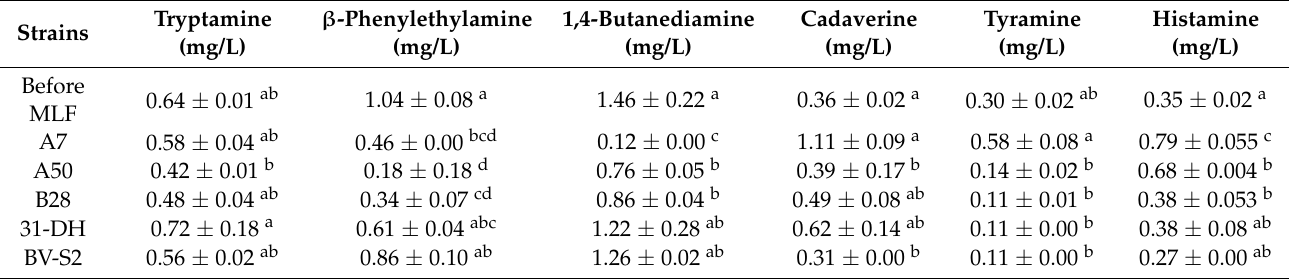
Table 6. Biogenic amine in cabernet sauvignon